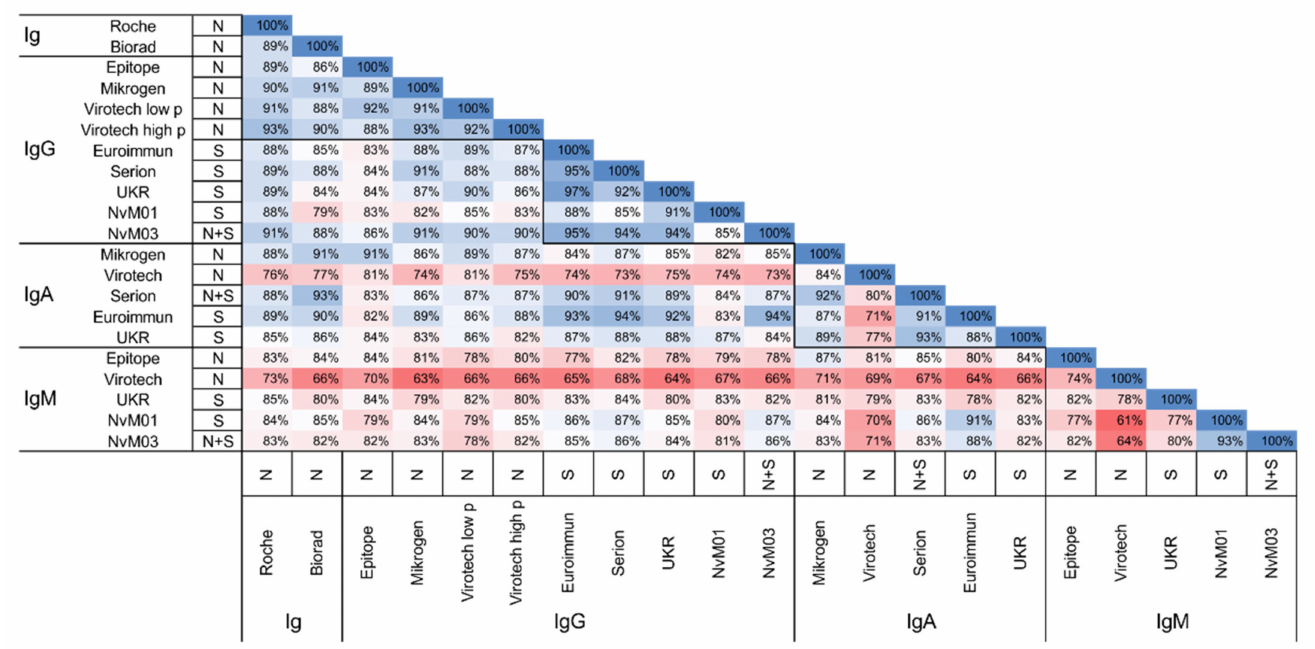
Figure 2. Percent agreement for all test combinations. Calculations based on the panel of positive sera. Detected antibody isotype, and used antigen of each test is given. A color gradient illustrates the percent agreement (red = low; white = in-termediate; blue =